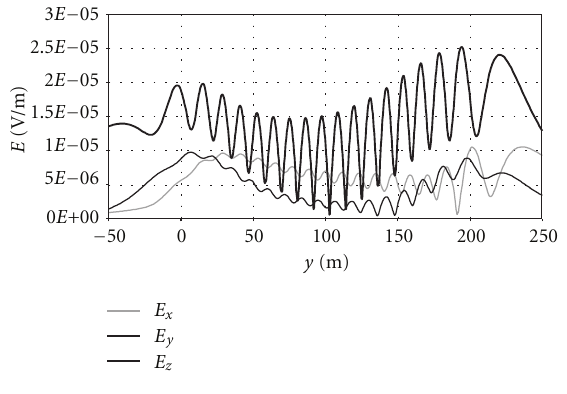
Figure 9: Radiated electric field.